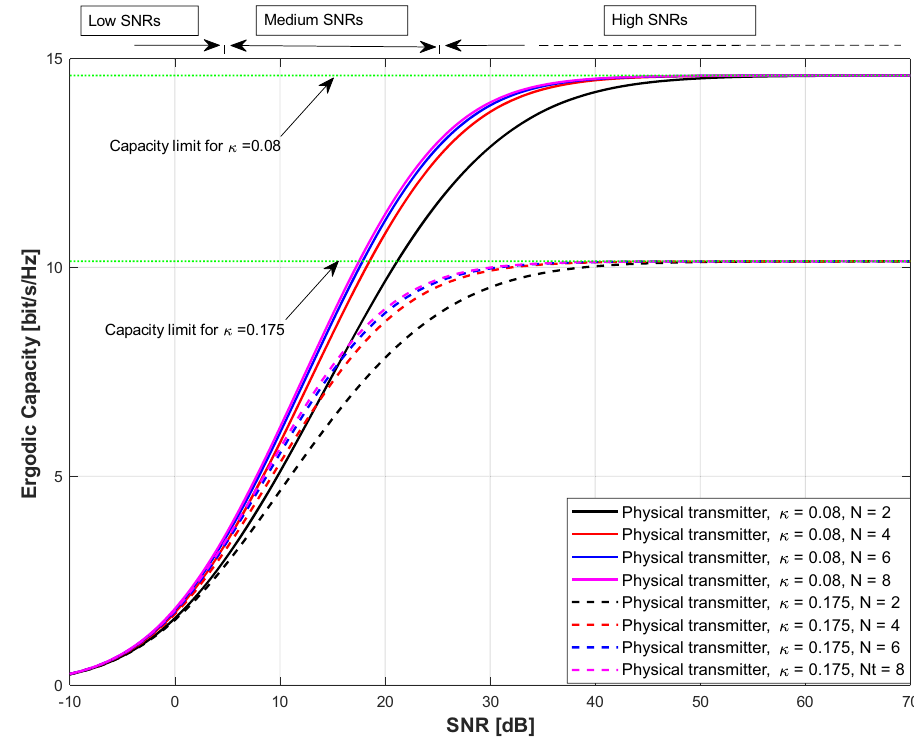
Figure 4: The ergodic capacity of the correlated MIMO channel in the case of physical transmitter with M 2 = , N 2, 4, 6, 8 { } ∈ , κ 0.08, 0.175 { } ∈ , and α 0.4 =